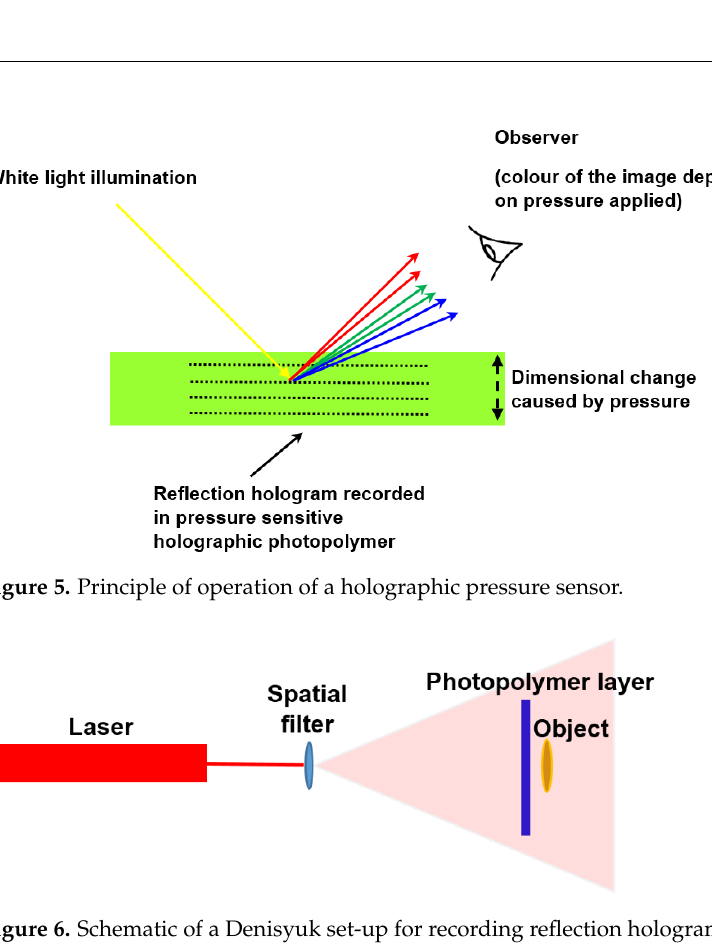
Figure 6. Schematic of a Denisyuk set-up for recording reflection holograms.